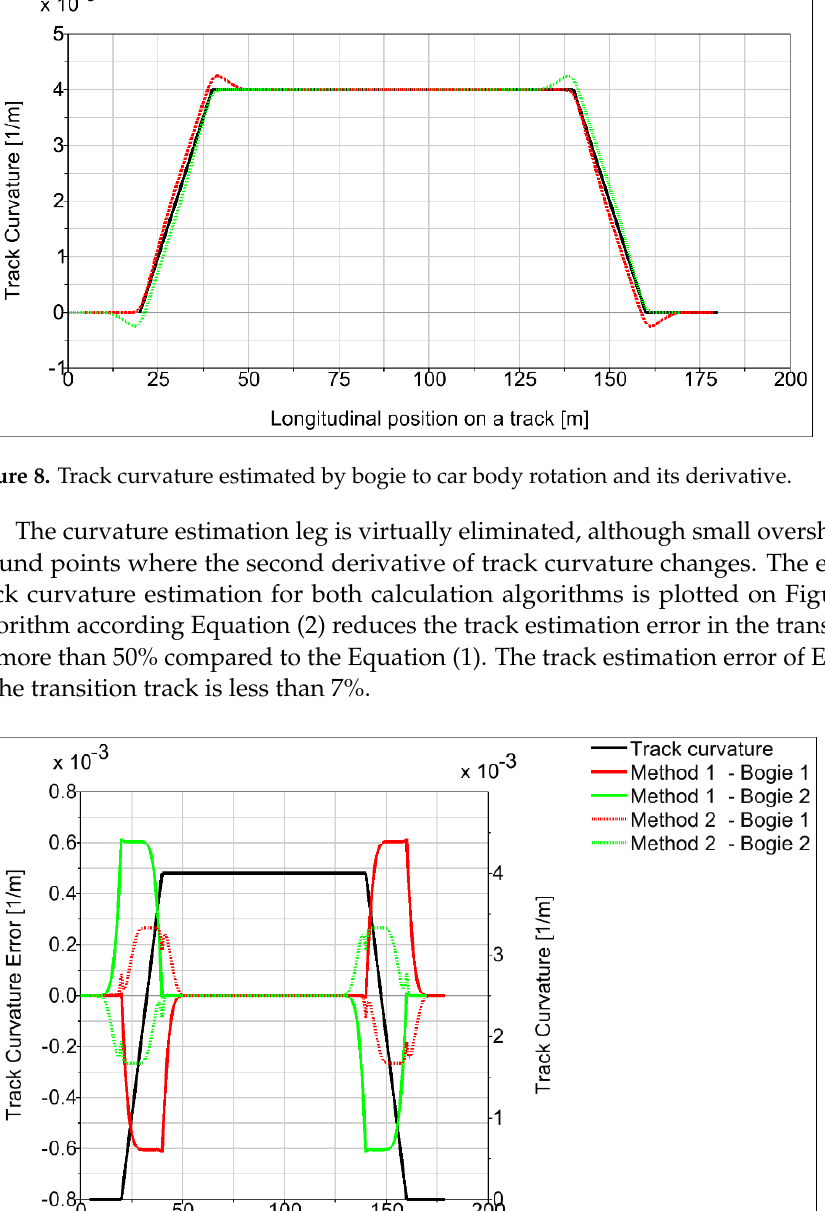
Figure 9. Comparison of track curvature estimation error. One problem is that the assumption of wheelsets that are perfectly aligned with the track centreline is not fully satisfied. A wheelset can move towards the track centreline in the lateral direction within the gauge clearance. Consequently, the angles of rotation of the first and second bogie differ, and vary in dependence of many parameters such as wheel and rail profiles, creep coefficients, value of unbalanced lateral acceleration, or torque caused by lateral deflection of flexi-coil springs. Typically, the leading bogie exhibits